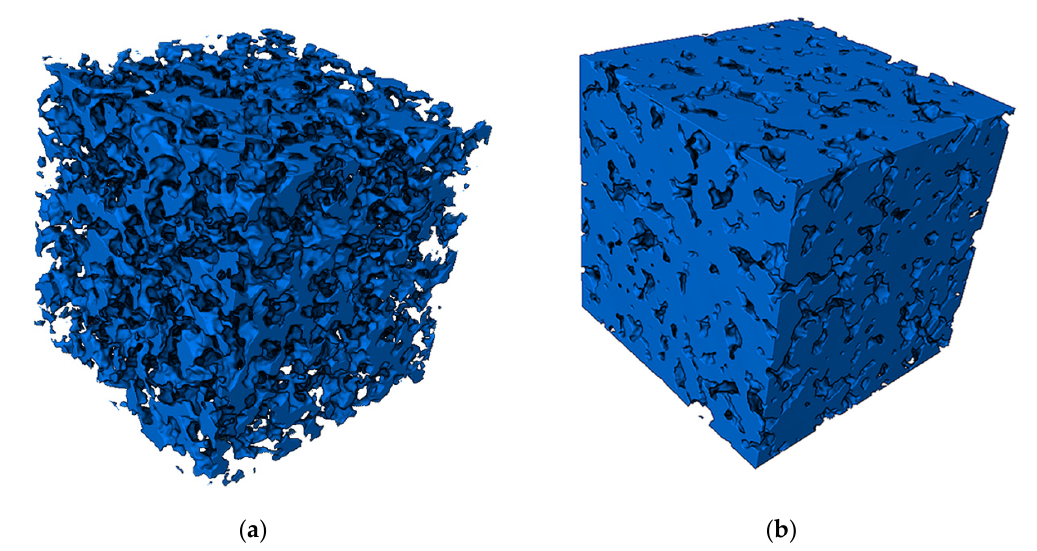
Figure 6. Solid model of porous material: ( a ) Pore structure (watershed); ( b ) Matrix structure (solid).